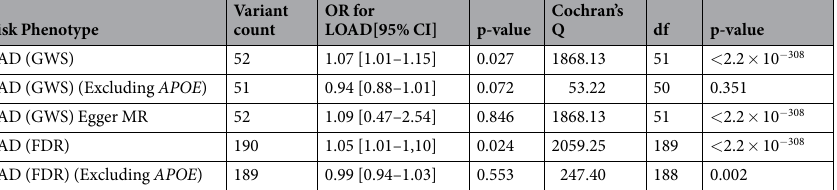
ε 2 allele (rs7412) and the APOE ε 4 allele (rs429358) were also included in the figure. Table 2 shows the linkage disequilibrium (LD) structure (with D ′ and r 2 ) between the variants within the APOE region. Investigation of the LD structure between the four variants, indicated that rs7412 (the APOE ε 2 allele) had a weak r 2 with the other variants (rs6857: 0.01, rs429358: 0.01 and rs4420638: 0.02), but moderate to high D ′ (rs6857: 0.71, rs429358: 0.68 and rs4420638: 1.00) and with complete LD with rs4420638. Different LD observa- tions for r 2 and D ′ reflect the differing allele frequencies between rs7412 and the other variants (eTables 4 and 5).